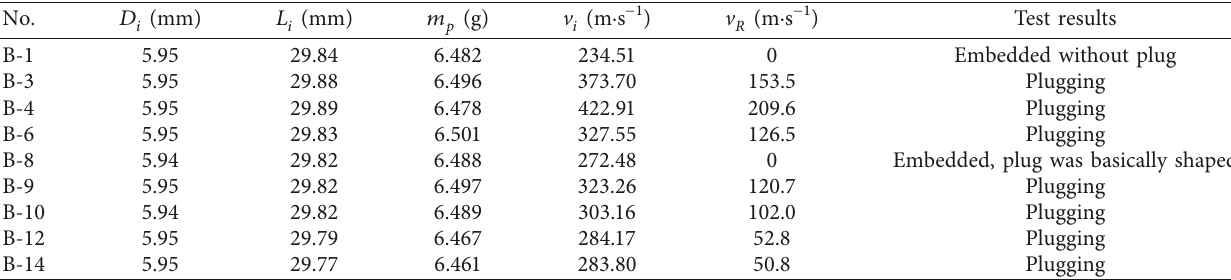
Table 3: Results of the ballistic test for Q235B steel